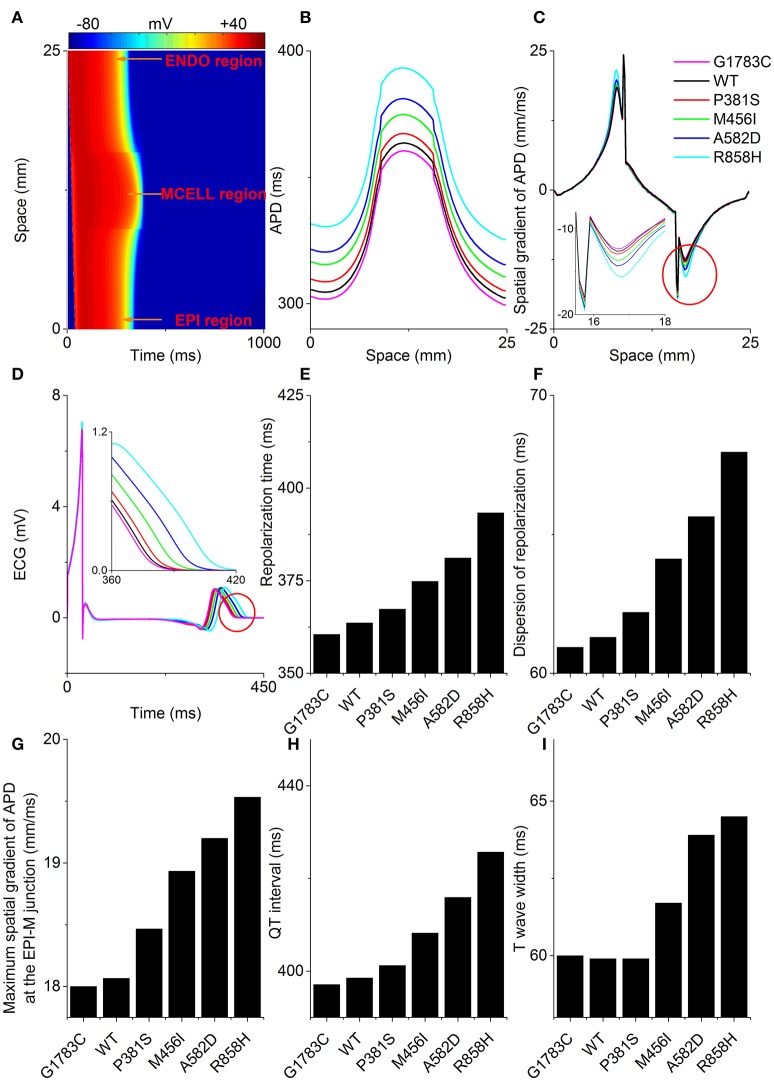
Space-time plot of action potential propagation and the computed pseudo-ECG. (A) Color mapping of membrane potential of cells along the one-dimensional (1D) strand from blue (−86 mV) to red (+42 mV). Space runs from the endocardial (ENDO) region to the midmyocardial (MCELL) and epicardial (EPI) regions. Spatial distribution of action potential duration (APD, B), spatial gradient of APD (C), and pseudo-ECGs (D) corresponding to the G1783C (Magenta), wild-type (WT, Black), P381S (Red), M456I (Green), A582D (Blue), and R858H (Cyan) conditions, respectively. Computed repolarization time (RT, E), dispersion of repolarization (DOR, F), maximum spatial gradient of APD (MSGA) at the epicardial- and midmyocardial- (EPI-M) junction (G), QT interval (H) and T wave width (I) are shown. From bottom to top, curves for the spatial distribution of APD are for the G1783C mutation, for the WT condition, for the P381S mutation, for the M456I mutation, for the A582D mutation and for the R858H mutation, respectively. Changes in the spatial gradient of APD at the EPI-M junction (marked with a red circle) are indicated by an enlargement of the (C). Changes in the T wave (marked with a red circle) are indicated by an enlargement of the (D). RT, DOR, MSGA at the EPI-M junction and QT interval augment with an increase in APD. T wave widths show no apparent differences between G1783C, WT and P381S.